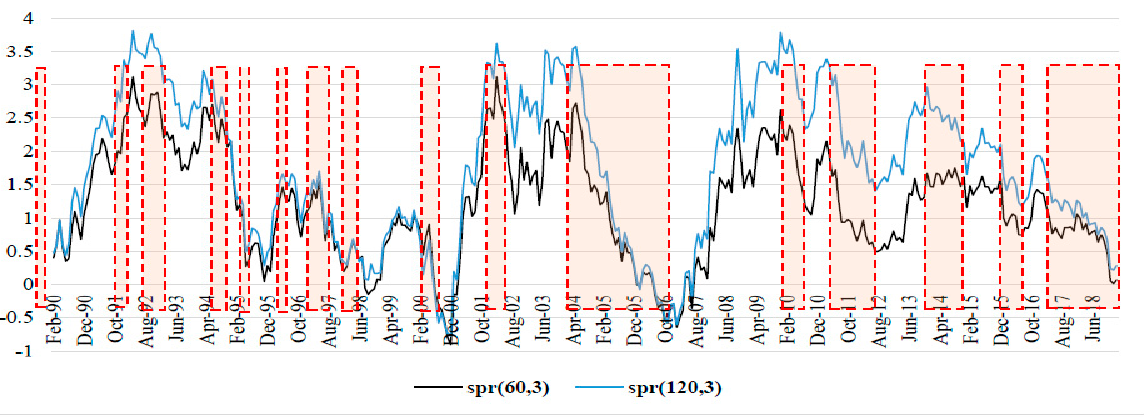
Figure 7. Yield curve-US.